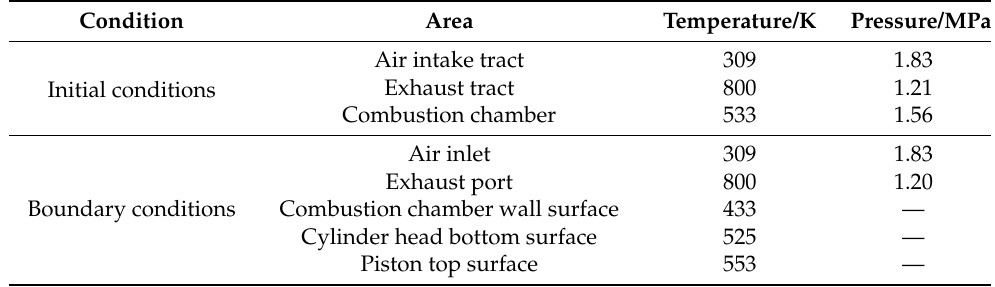
Table 2. Calculation model initial conditions.